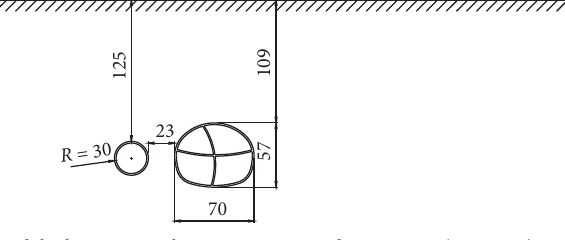
Figure 3: Model placement relative position and geometry (unit: